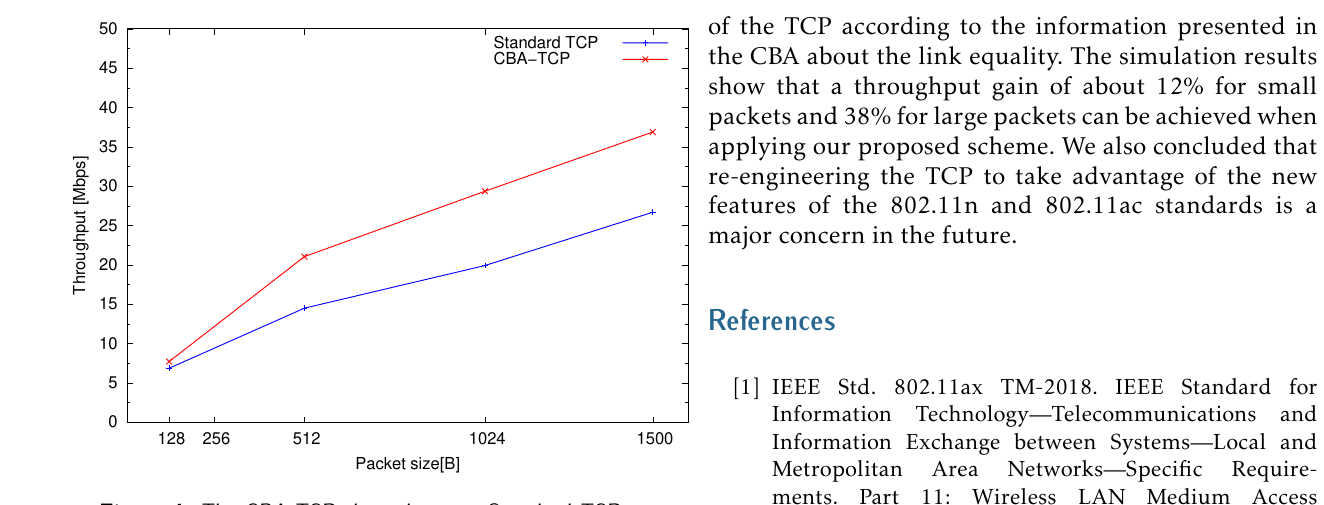
Figure 4. The CBA-TCP throughput vs. Standard TCP